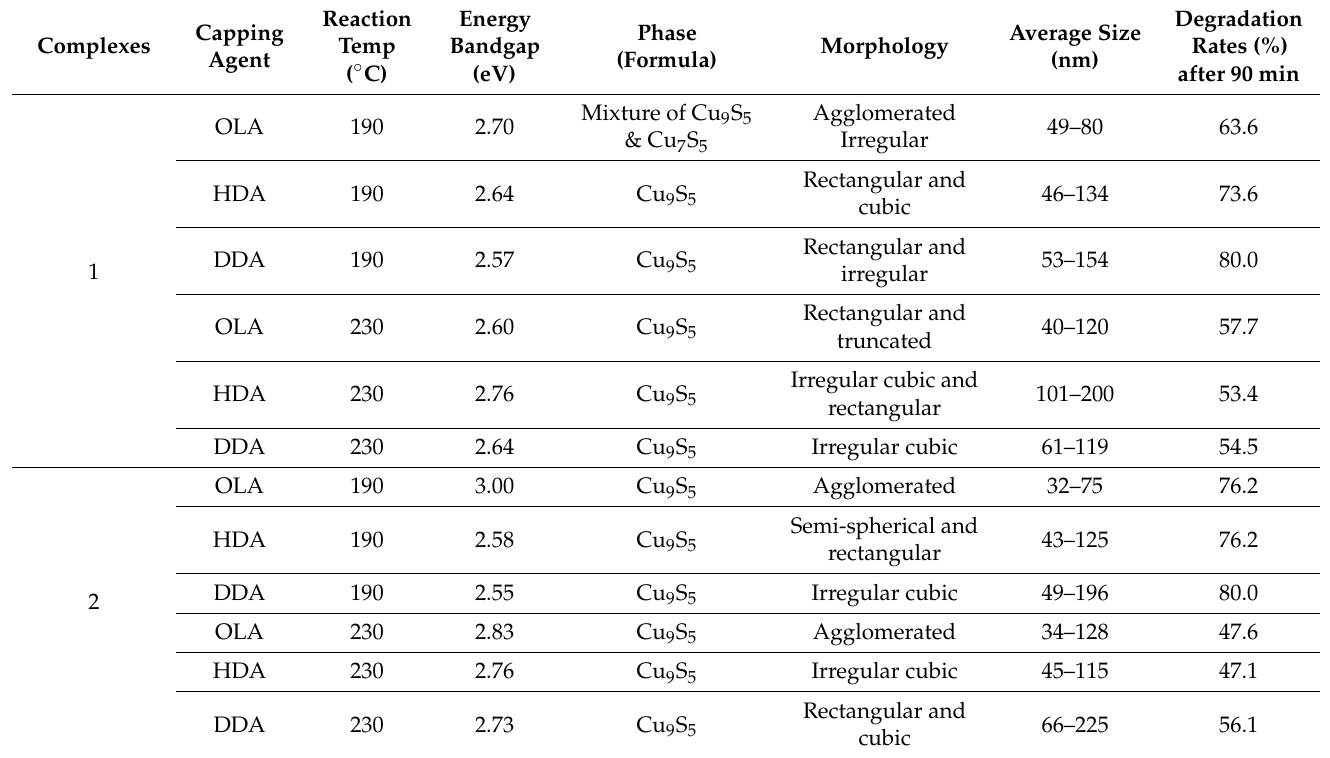
Table 5. Summary of the reaction conditions, sizes, shapes optical, and photocatalytic properties of copper sulphide